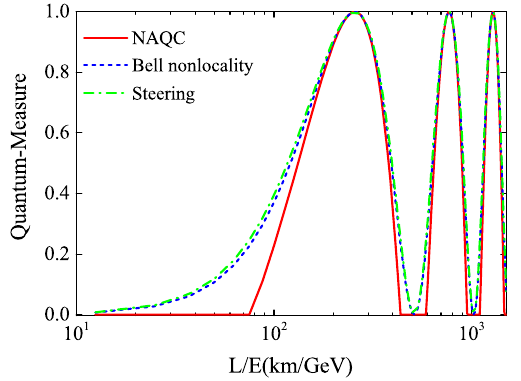
Fig. 6 The quantifiers of NAQC (solid line, red) in Eq. (10), Bell nonlocality (dashed line, blue) in Eq. (12) and Steering (dotted-dashed line, green) in Eq. (14) with respect to the distance traveled per energy L / E for the initial muon flavor